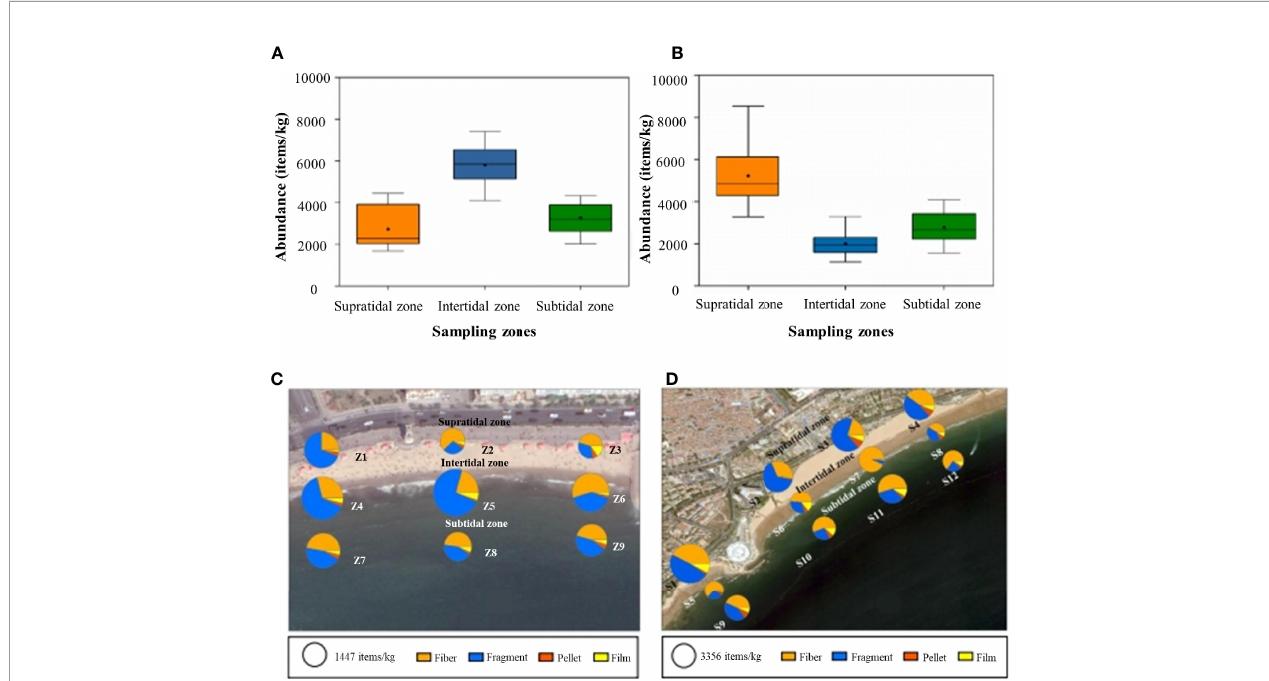
FIGURE 6 | The abundance and shape of MPs in the sand samples collected from BB1 (A, C) and BB2 (B, D) . Sites Z1 – Z3 and S1 – S4 were located in the supratidal zones. Sites Z4 – Z6 and S5 – S8 were located in the intertidal zones, and sites Z7 – Z9 and S9 – S12 were located in the subtidal zones. Sites S1, S5, and S9 were selected within the business and leisure areas. Sites S2, S6, and S10 were located close to the sewage outlet. Sites S3, S7, and S11 were located in the areas of bathing, and sites S4, S8, and S12 were located in the zone with less human activities. The size of the circle represents the concentration, and the area of the sector corresponded to the proportion of the